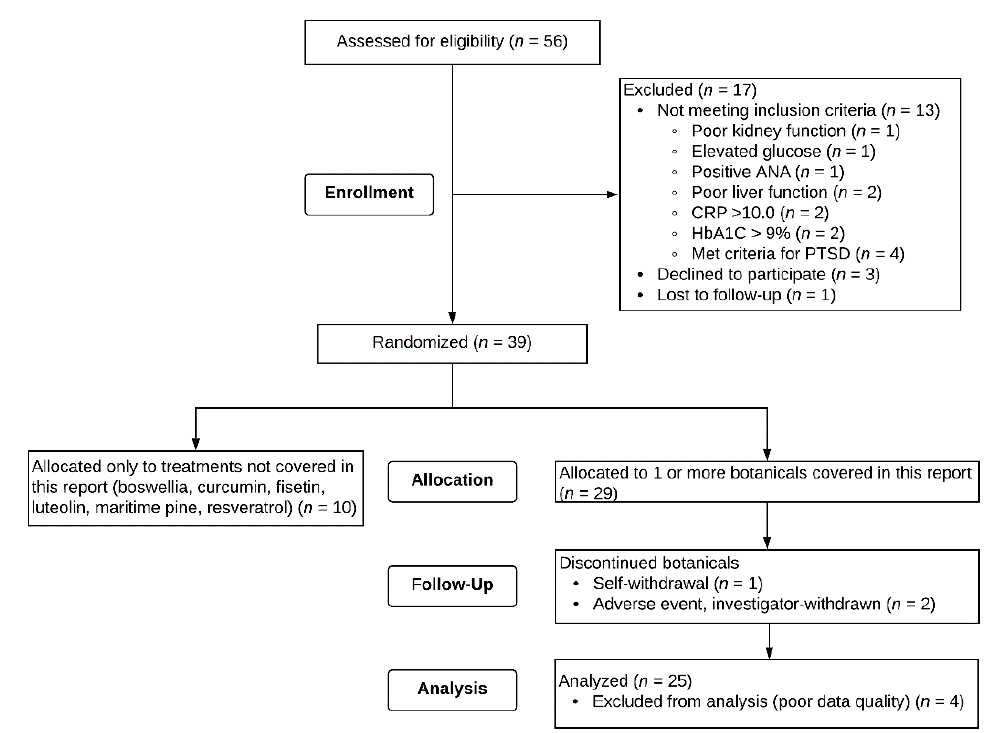
Figure 3. CONSORT Flow diagram. The three participants who discontinued botanicals provided sufficient data to be included in analyses. Four participants could not be included in analyses due to unusable outcome responses (two re- ported only “zeros” for GWI severity, and two gave all retrospective